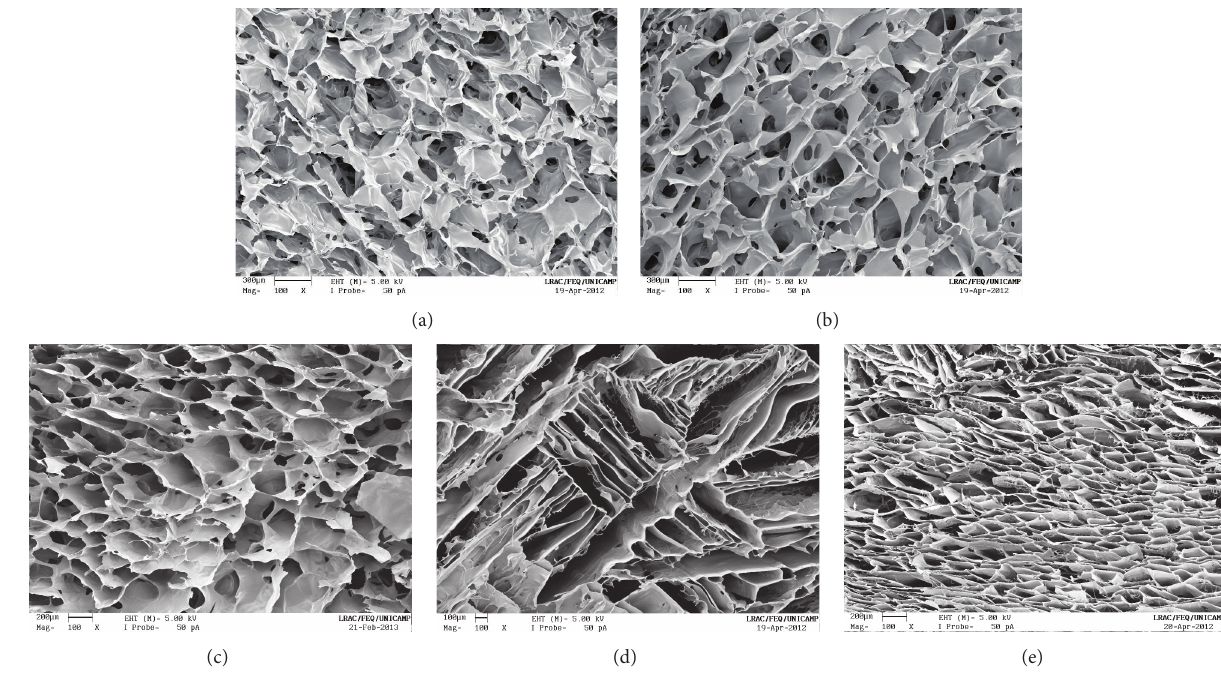
Figure 1: SEM micrographs of PCHTs. Cross-sectional morphologies of (a) PCHTs 1% ( − 20 ∘ C); (b) PCHTs 2% ( − 20 ∘ C); (c) PCHTs 3% ( − 20 ∘ C); (d) PCHTs 3% ( − 80 ∘ C); and (e) PCHTs 3% ( − 196 ∘ C). Original magnification is × 100 and the scale bar represents 200 𝜇 m.